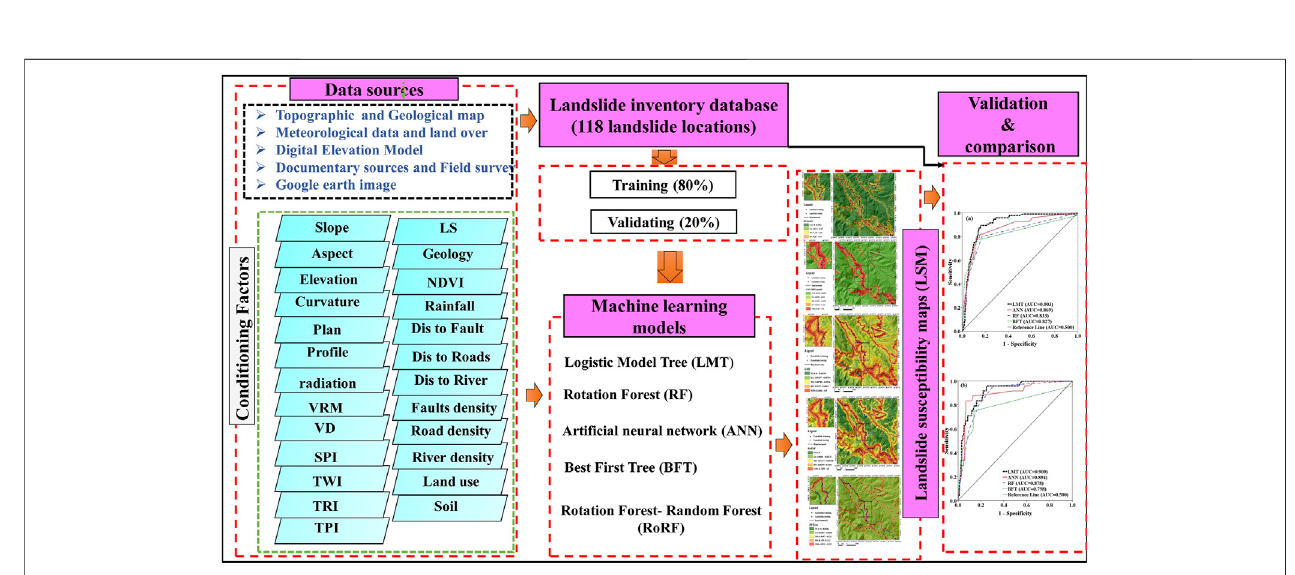
FIGURE 2 | The photographs of the landslides occurred in the study area.